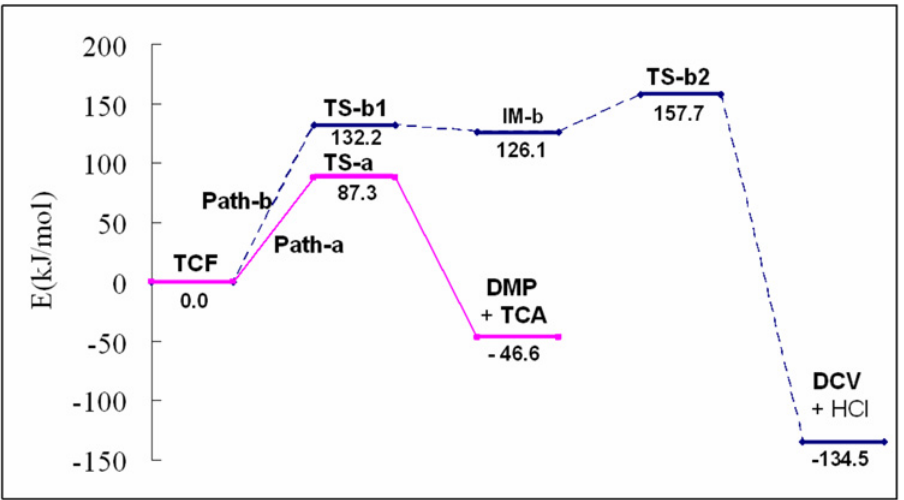
Fig 6. The schematic potential energy diagrams for the pyrolytic reactions of trichlorfon.